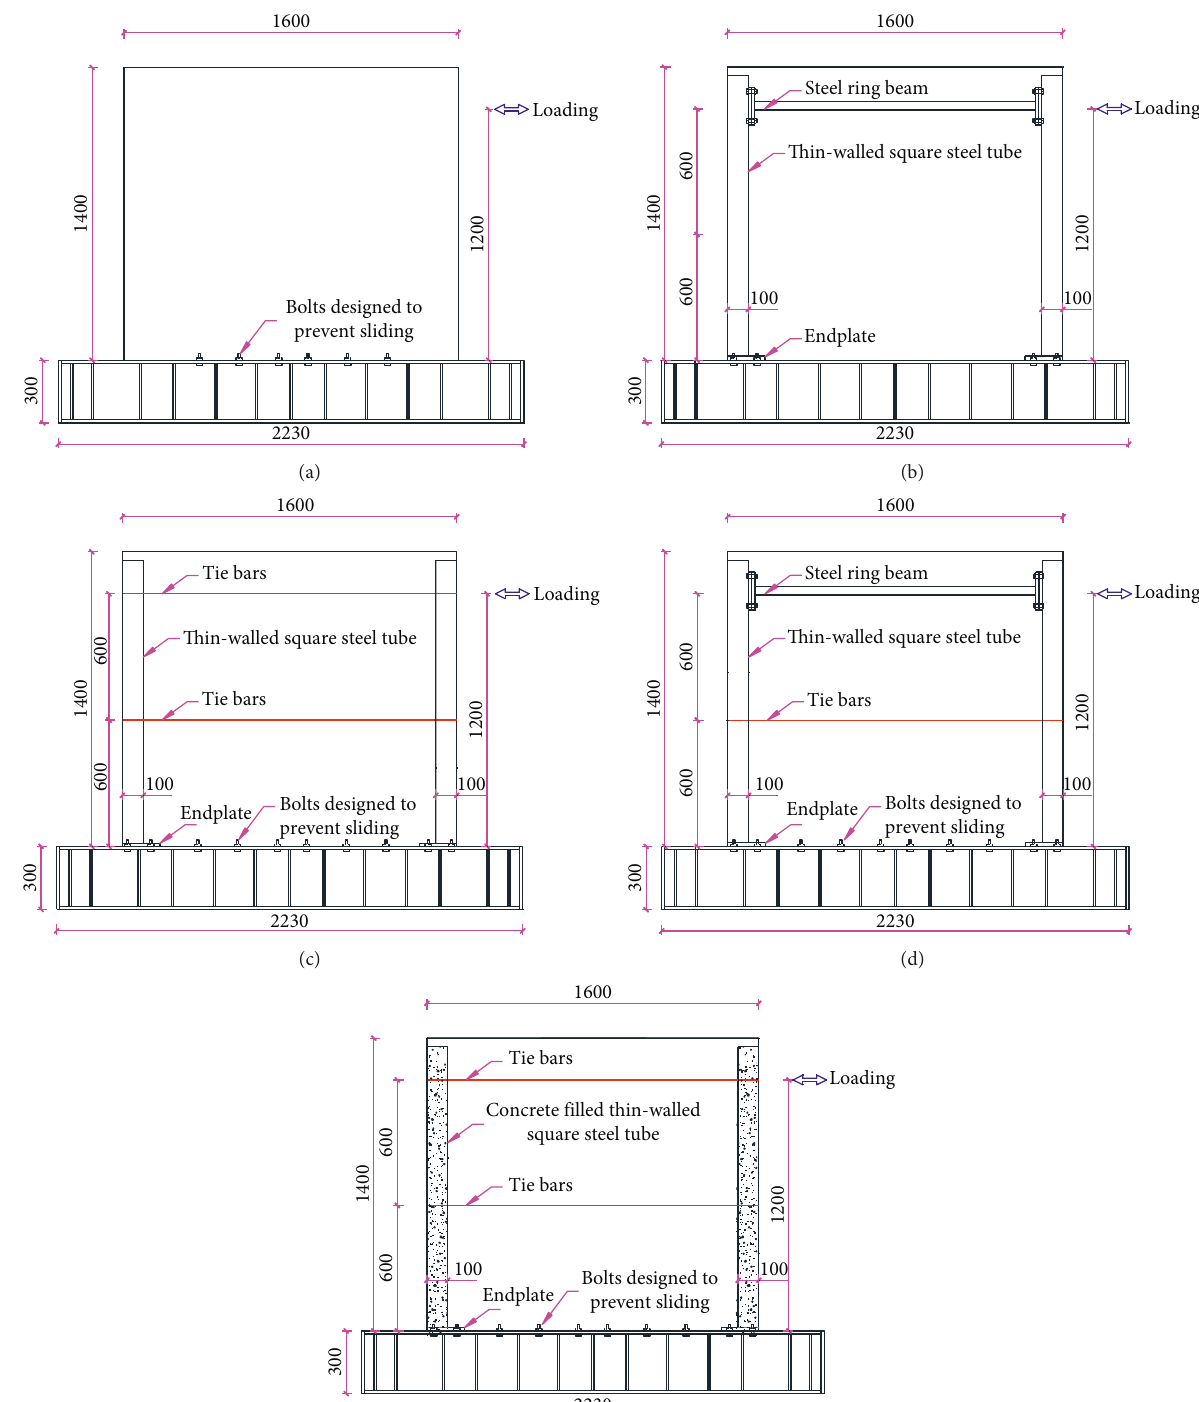
Figure 2: Geometry and details of the tested specimens. Note: CSRE is not shown for clarity. (a) Specimen Q-1 (without confining tie- column elements). (b) Specimen SF (steel frame only). (c) Specimen W-1. (d) Specimen W-2. (e) Specimen of 0.4%. When the drift reached 4%, interval steps of 0.8% Each test was initiated at interval step of 0.1% drift drift were imposed to the specimens until failure or in- ratio until 0.8%. In the range of 0.8% ∼ 2% drift, the stability. The lateral cyclic loading protocol is shown in specimen was cycled at interval steps of 0.2%. In the range of 2% ∼ 4% drift, the specimen was cycled at interval steps